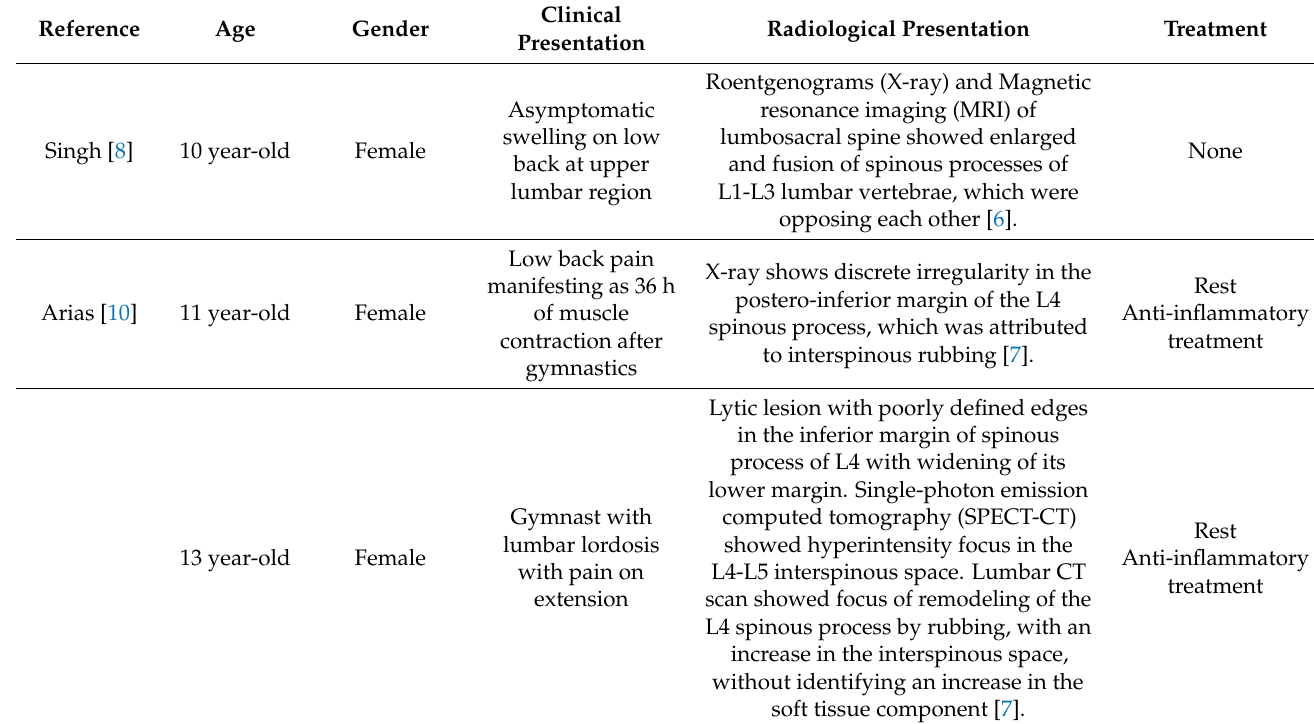
Table 1. Summary of the literature of pediatric clinical presentations of Baastrup’s